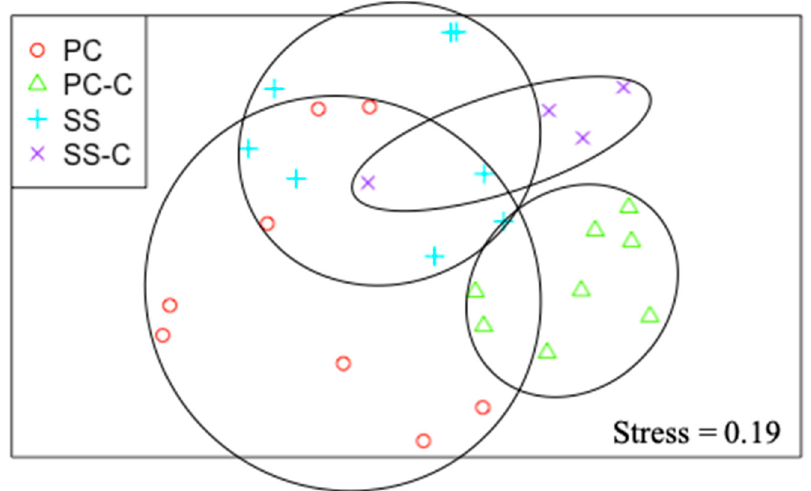
Figure 4. MDS of average biofouling communities on both UVC-exposed polycarbonate (PC) and stainless steel (SS) and nonexposed polycarbonate (PC-C) and stainless steel control surfaces (SS-C) following the 1 min/day exposure time.